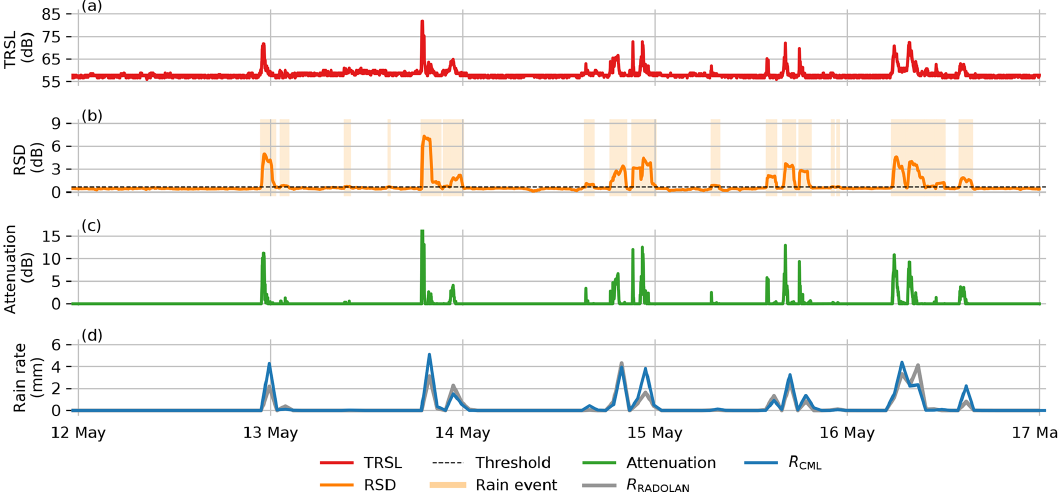
Figure 3. Processing steps from the TRSL to rain rate. (a) The TRSL is the difference between TSL and RSL (TSL minus RSL) – the raw transmitted and received signal level of a CML. (b) The RSD (rolling standard deviation) of the TRSL with an exemplary threshold shows the resulting wet and dry periods. (c) The attenuation is the difference between the baseline and the TRSL during wet periods. (d) The derived rain rate is resampled to an hourly scale in order to compare it to the reference